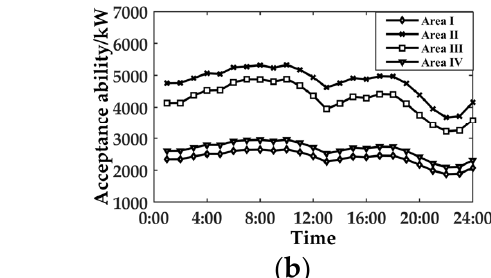
network. ( a ) Weekdays, ( b ) Weekends.